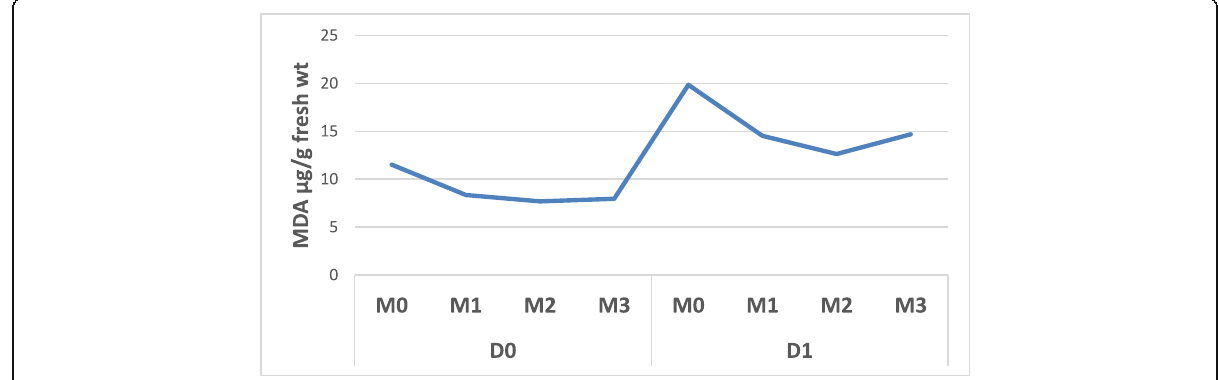
Fig. 3 Effect of melatonin (0, 50, 100, and 150 mM) on MDA ( μ mol/g fresh wt.) of M. oleifera plants subjected to drought stress (normal irrigation and skipping two irrigation times)